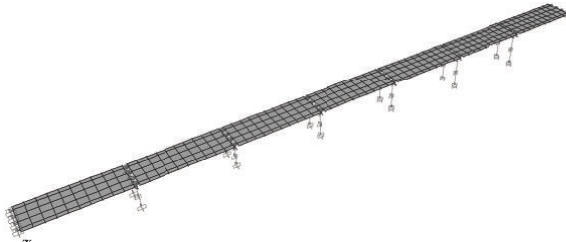
Figure 9: Three-dimensional FE model of the seven central